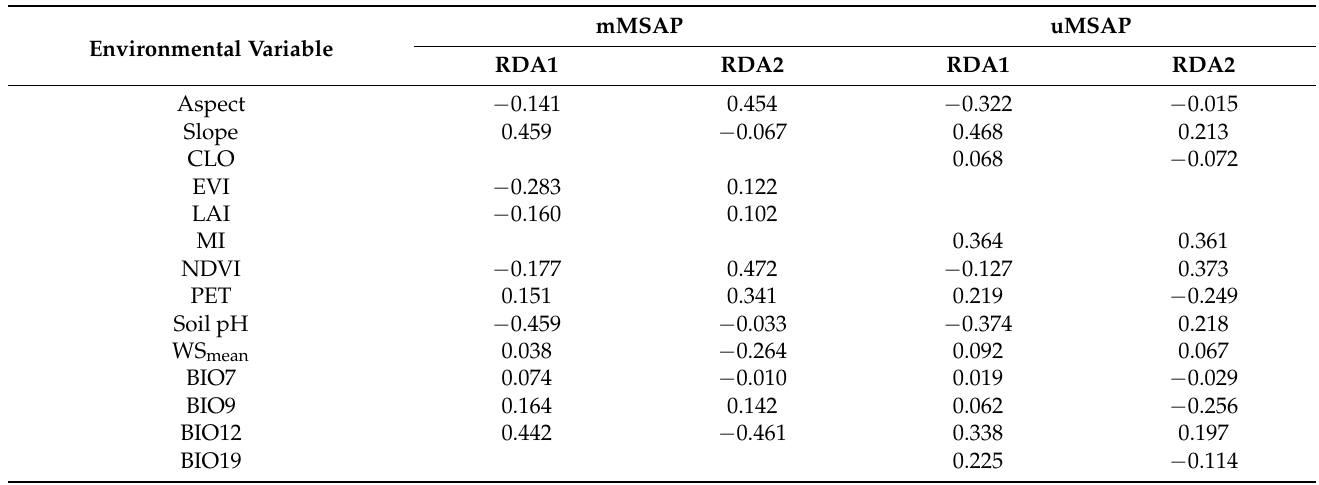
Table 4. The pRDA biplot scores for constraining environmental variables associated with epigenetic variation controlling for the geographic